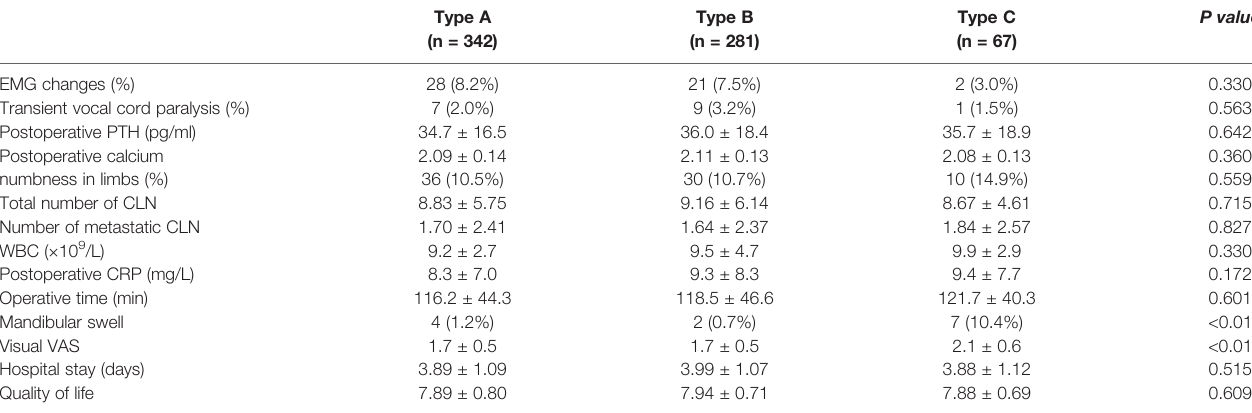
TABLE 2 | Effective assessment of surgical results in the groups of type A, B, and C malocclusion.